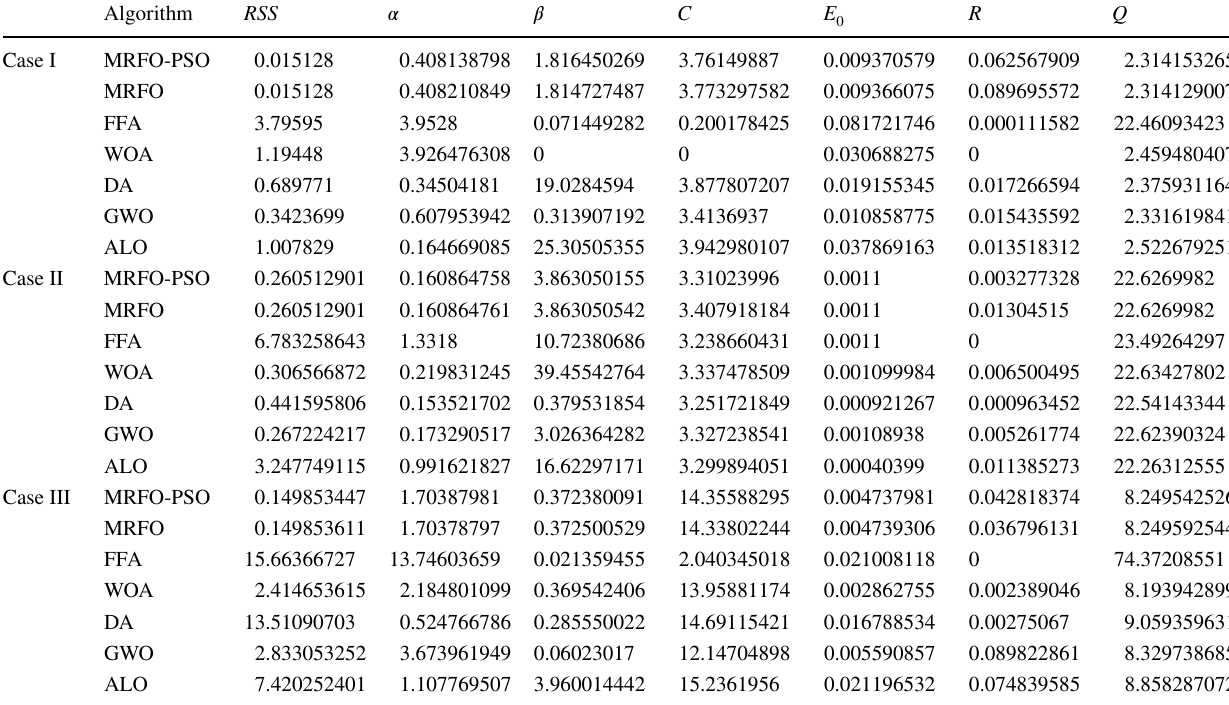
Table 8 The extracted parameters of the different algorithms for the studied